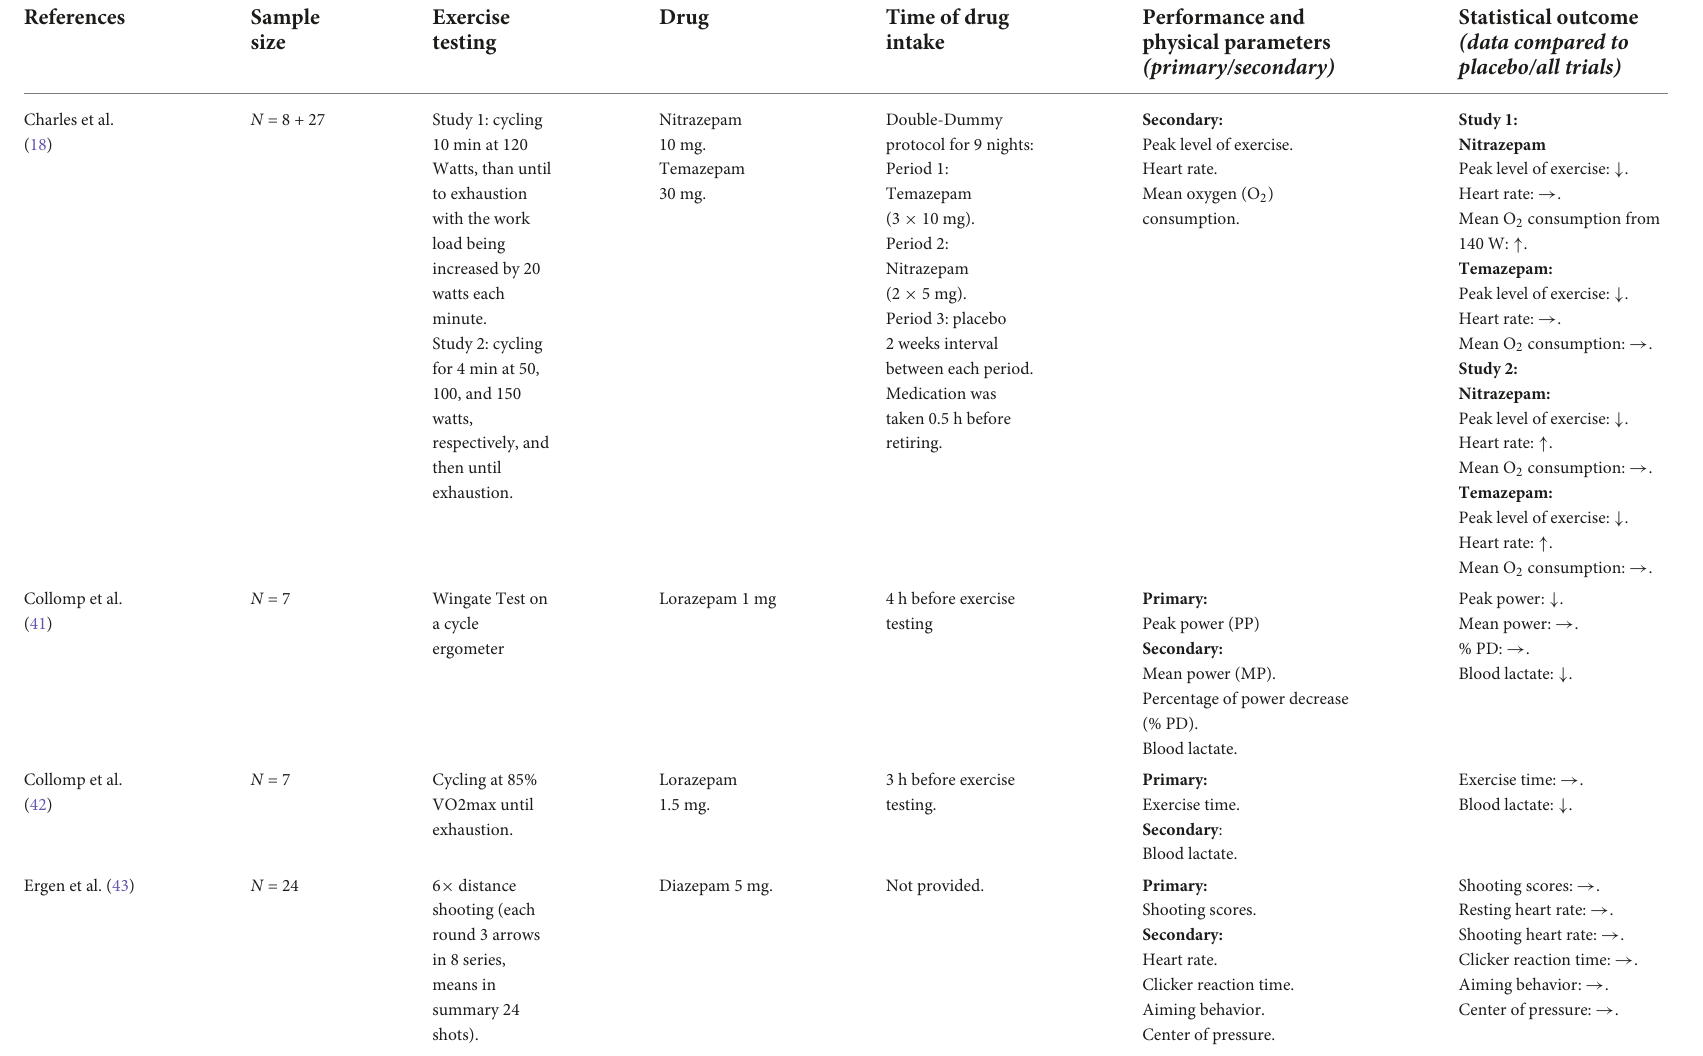
TABLE 4 Sedatives: experimental testing, drug and measured performance